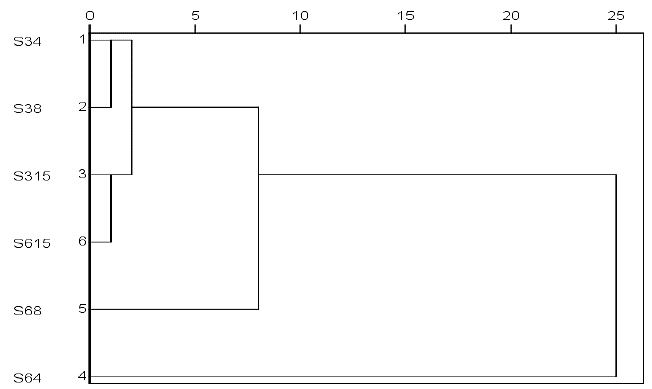
Figure 4. Substrate water content cluster diagram under different depths.